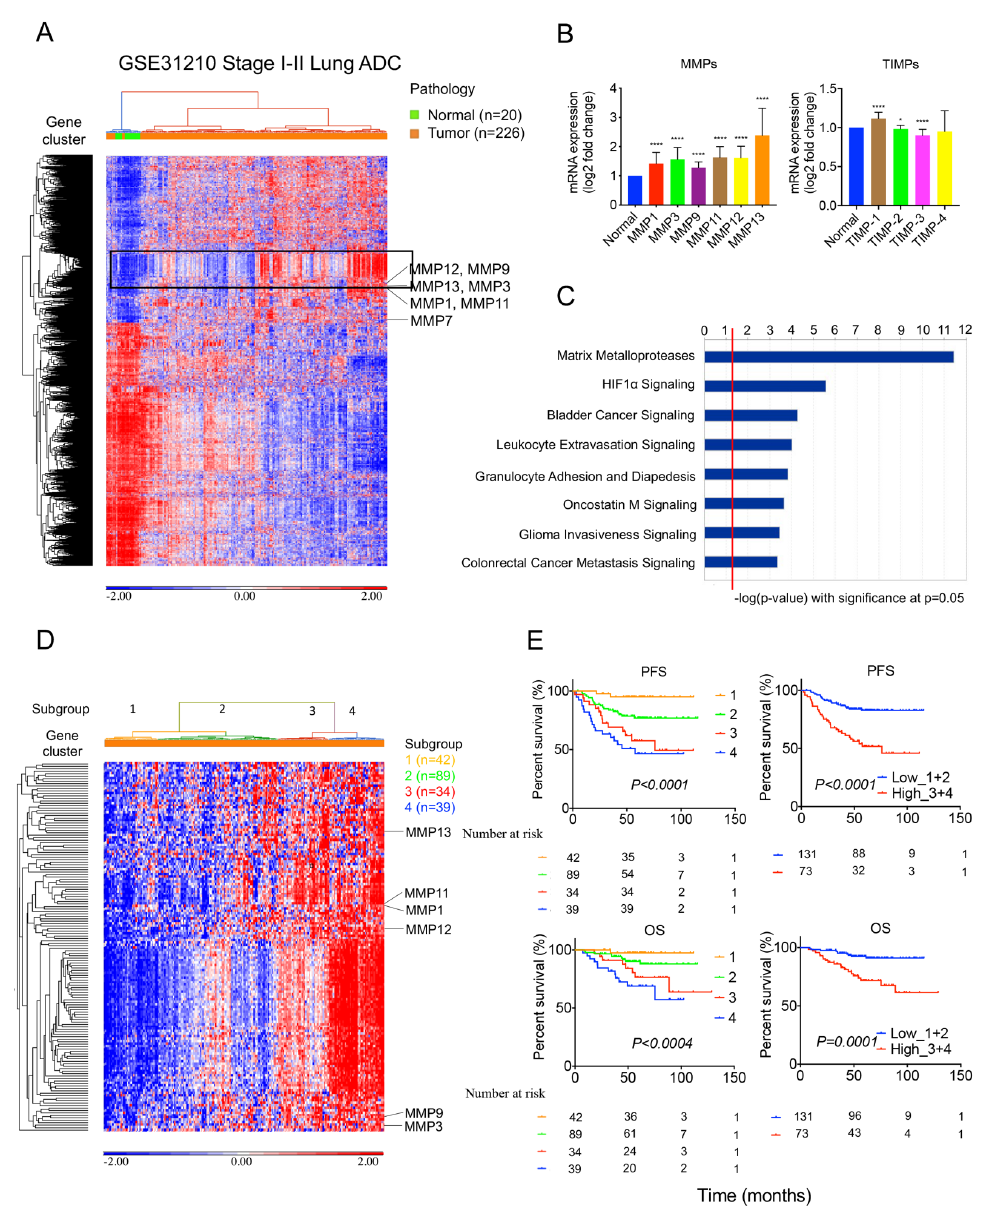
Figure 1. MMPs increase expression in lung tumors and are associated with survival outcomes in the GSE31210 cohort; 226 lung adenocarcinoma patient samples and 20 normal lung samples from the GSE31210 stage I–II lung adenocarcinoma cohort were analyzed: ( A ) An unsupervised hierarchical clustering heatmap of differentially expressed genes between tumor and normal lung tissue was performed. A 150-gene cluster with enriched MMPs was identified (square). ( B ) The MMPs, including MMP1 , MMP3 , MMP7 , MMP9 , MMP11 , MMP12 , and MMP13 , increased expression in tumors compared to normal lung tissue. TIMP-1 increased expression in tumors, but TIMP-2 and TIMP-3 decreased expression in tumors compared to normal lung tissue. Data shown are mean ± S.D. **** p < 0.0001 and * p < 0.005 using Student’s t test. ( C ) Ingenuity pathway analysis of the